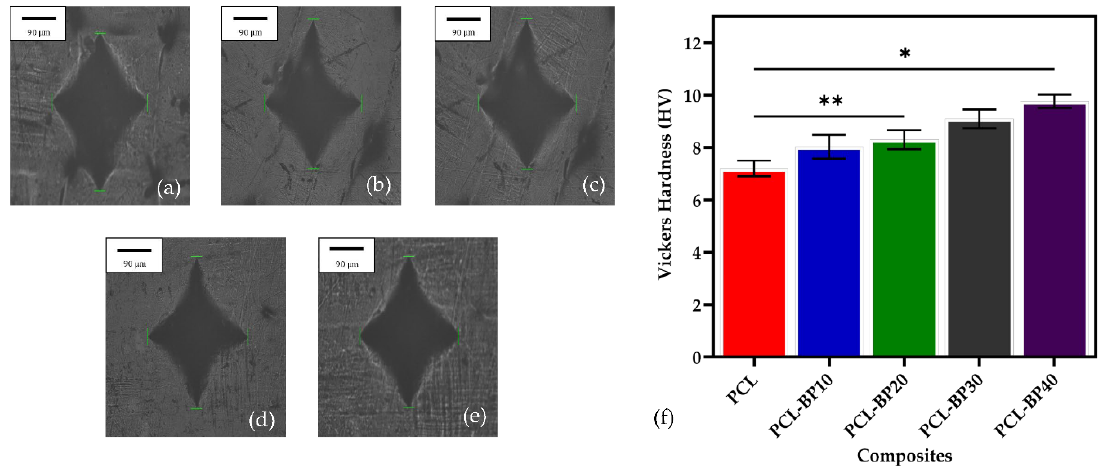
Figure 10. Images of hardness for PCL and PCL-BP composites: ( a ) PCL; ( b ) PCL-BP10; ( c ) PCL-BP20; ( d ) PCL-BP30; ( e ) PCL-BP40; and ( f ) Vickers hardness values ( n = 3, * p ≤ 0.05, ** p ≤ 0.01).